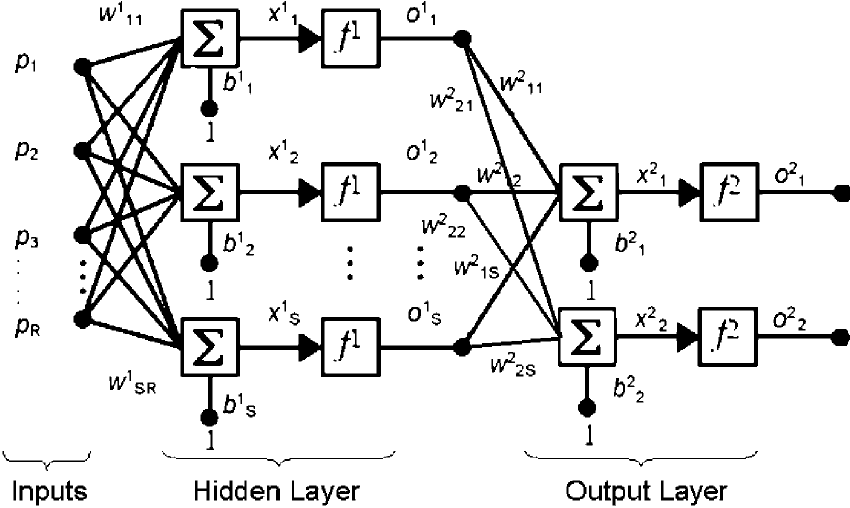
Fig. 3. Architecture of the METU Fuzzy Neural Network (METU-FNN) module where p 1 is defuzified input. Table 1. Inputs and outputs of the METU-FNN.